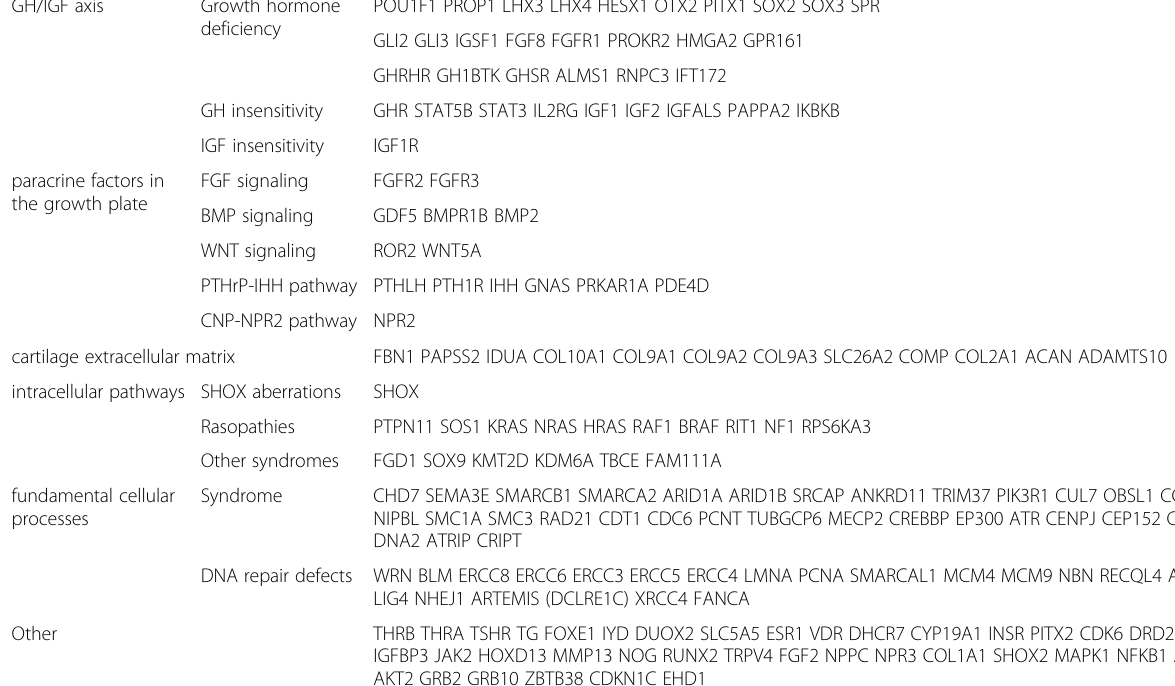
Table 1 List of 166 genes in gene panel GH/IGF axis